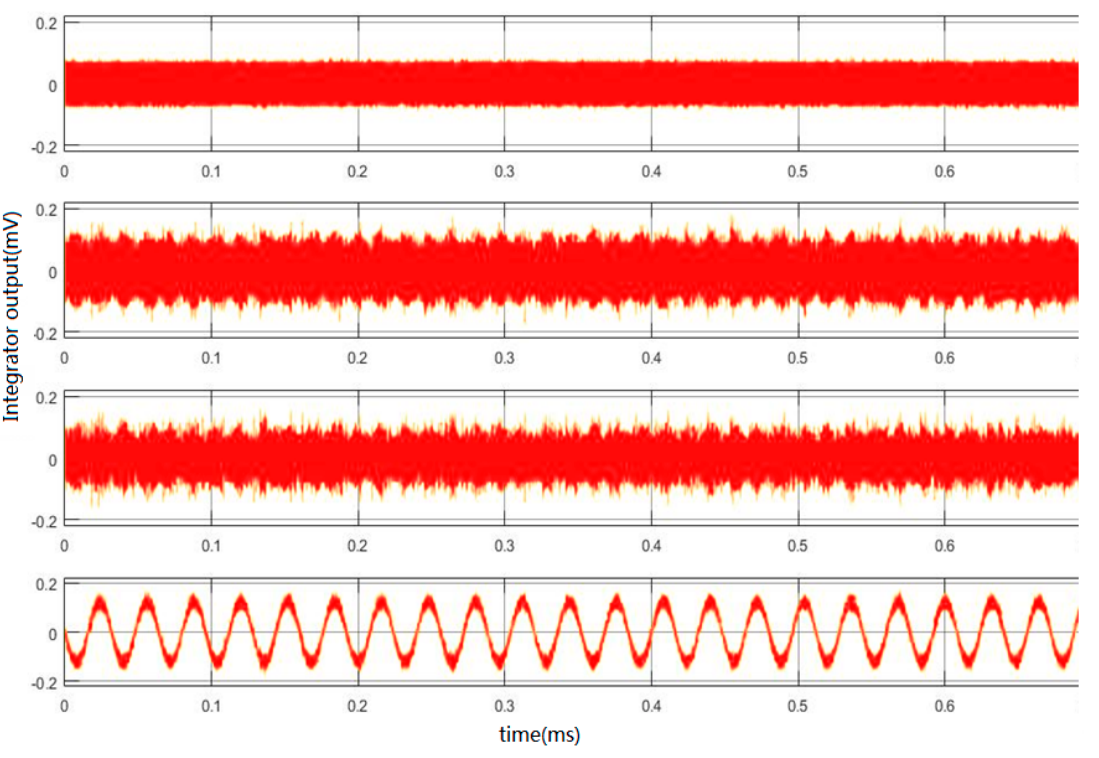
Figure 8. Output waves of each stage of the integrator.